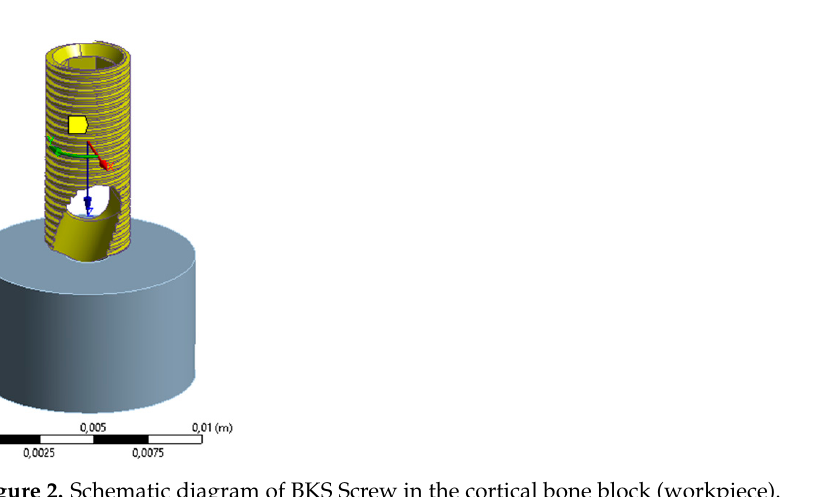
Figure 3. Thermal-Structural Analysis. Bone total deformation 0.013 mm.